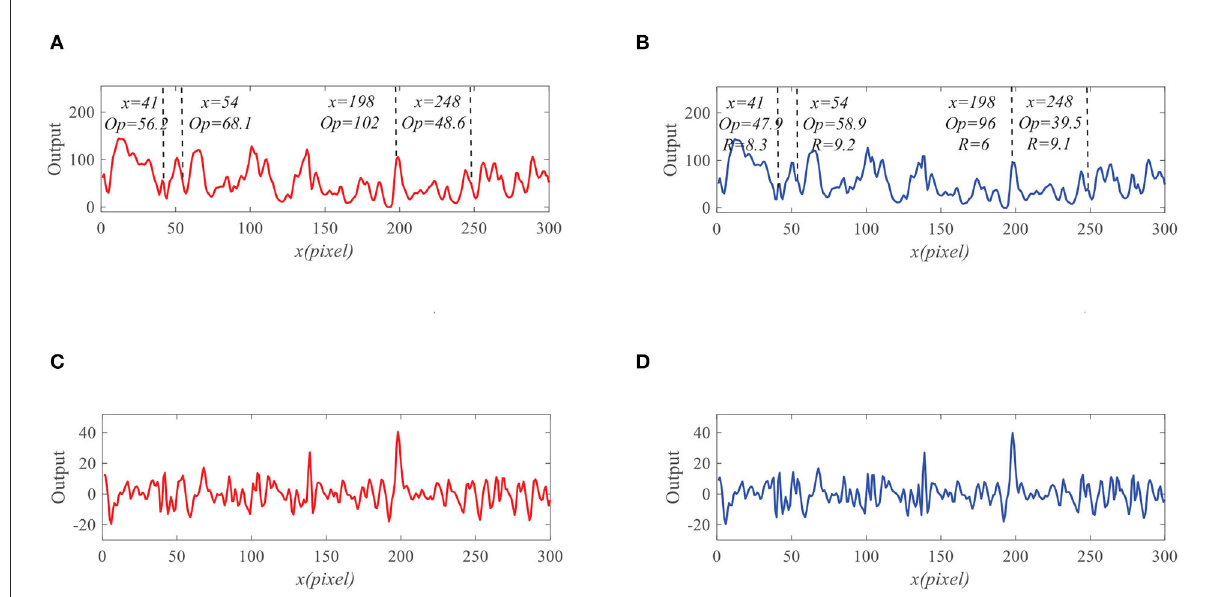
FIGURE8 The outputs of the ommtidia and LMCs neurons. (A) The outputs of ommatidia without feedback. (B) The outputs of ommatidia with feedback. (C) The outputs of LMCs without feedback. (D) The outputs of LMCs with feedback.